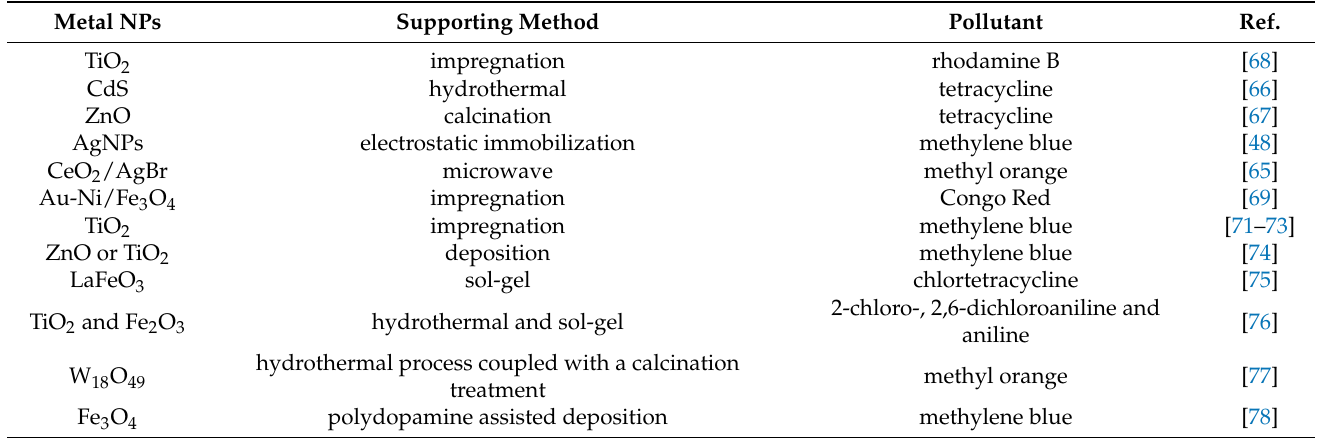
Table 3. Metal nanoparticles supported on HNTs for application as photocatatalysts for pollutant removal.